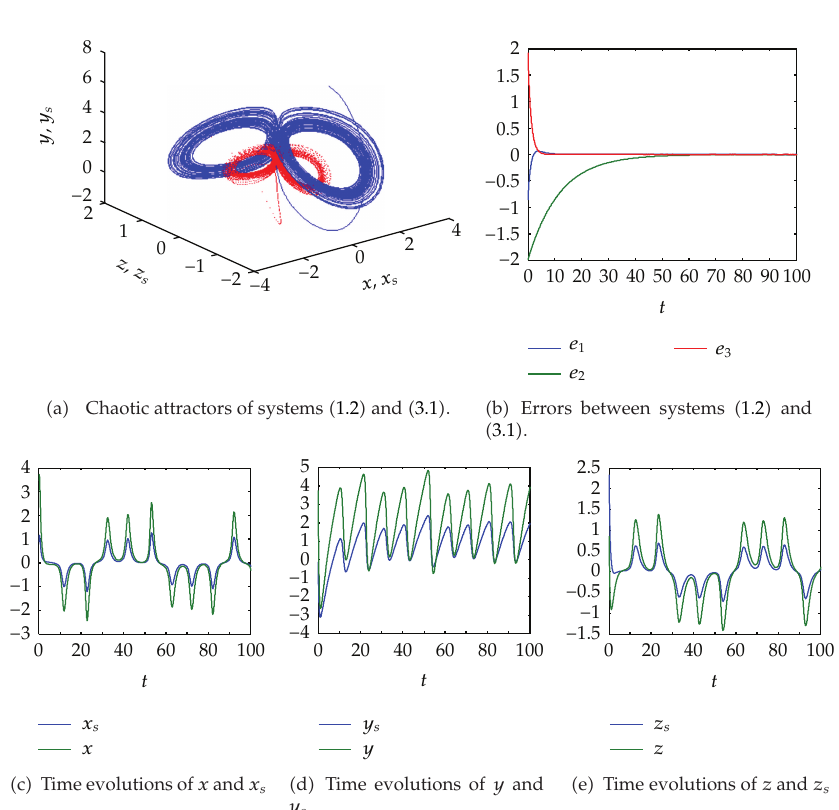
Figure 2: Synchronization errors between the master system (cid:7) 1.2 (cid:8) and the slave system (cid:7) 3.1 (cid:8) with a (cid:5) 1, b (cid:5) 0 . 1, c (cid:5) 1 . 2, q (cid:5) 0 . 88, q (cid:5) 0 . 98, q (cid:5) 0 . 96, a (cid:5) 0 . 5, x (cid:7) 0 (cid:8) (cid:5) 3, y (cid:7) 0 (cid:8) (cid:5) 4, z (cid:7) 0 (cid:8) (cid:5) 1, x s (cid:7) 0 (cid:8) (cid:5) 0 . 5, y s (cid:7) 0 (cid:8) (cid:5) 0, 1 2 3 z s (cid:7) 0 (cid:8) (cid:5) 2 .